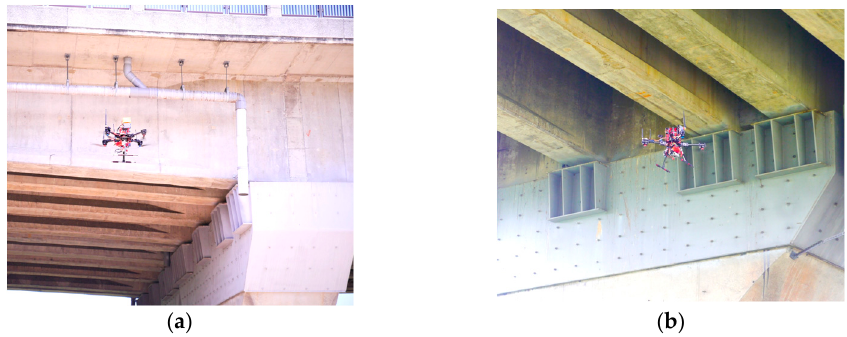
Figure 14. Bridge inspections performed by the self-assembled UAV: ( a ) operation on the side of the Wuling Bridge; ( b ) operation at the bottom of the Wuling Bridge.